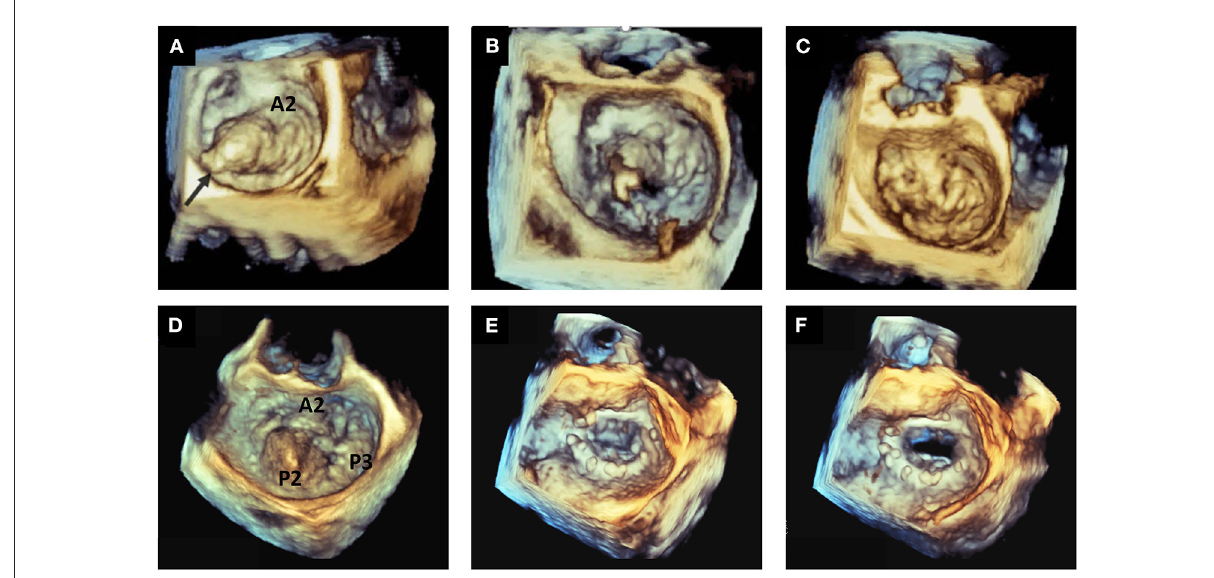
FIGURE6 Examples of surgical mitral valve repair. Top panels show an example of A2 flail with single chordal rupture [arrow, (A) ] corrected with the Neochord artificial chordae delivery system (B) obtaining the restoration of normal valve anatomy and competence (C) . Bottom panels show